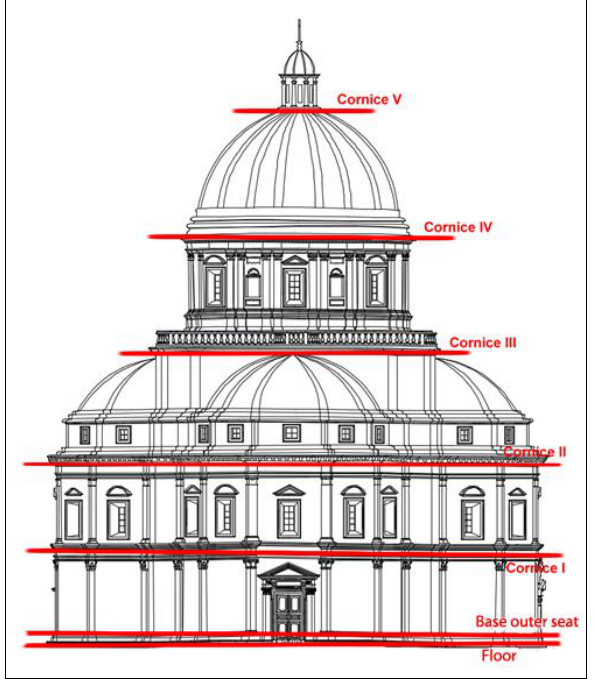
Figure 5. Location of some architectural elements For each element was computed the height difference  z between the highest and the lowest point (Tab.